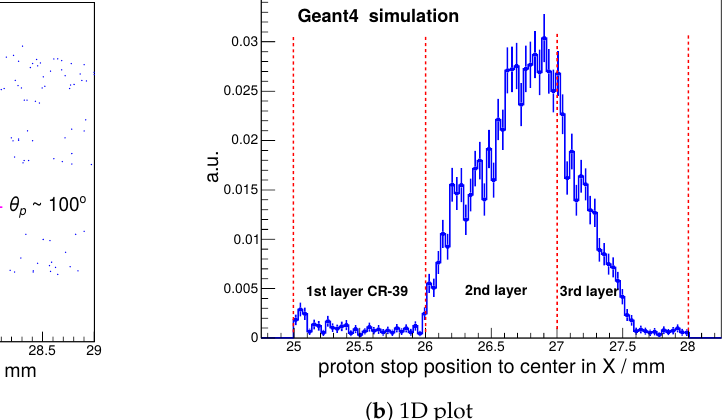
Figure 5. Geant4 simulation of protons emitted from the d - 3 He fusion reaction into a stack of CR-39 plates. ( a ) Range distribution of protons stopped in the stack vs. their initial kinetic energies. X = 0 is the center of the polarimeter with the foil-target. ( b ) Projection of the 2D distribution on the X axis. The vertical axis with an arbitrary unit (a.u.) of proton counts has been scaled from the weight of tracks in which a biasing technique is used to simulate relatively rare events